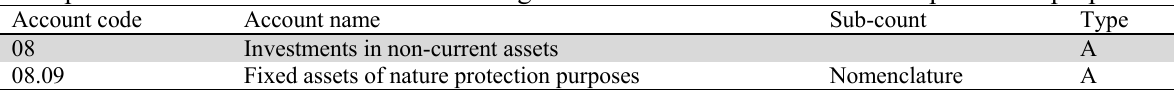
Excerpt from the Plan of Accounts: accounting of fixed assets intended for nature protection